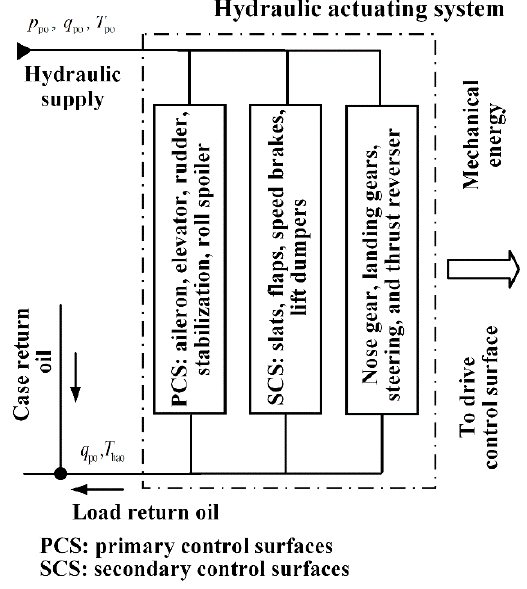
Figure 5. Thermal modeling mechanism of the hydraulic actuating subsystem.